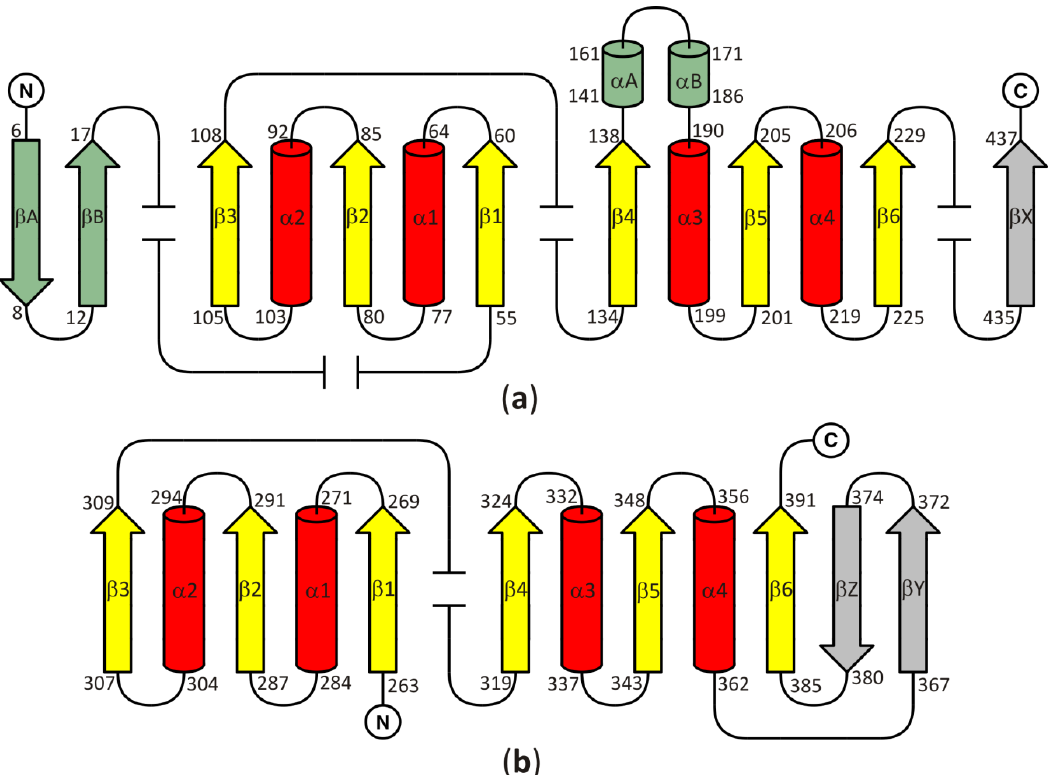
Figure 2. A topology diagram of the Rossmann fold in ( a ) the substrate-binding domain and ( b ) the cofactor-binding domain. Secondary structure elements present in the canonical Rossmann motif are shown in yellow and red. Additional, non-canonical β-chains present in all SAHases, in the central β-sheet, are shown in grey. The secondary structure elements present in the substrate binding-domain (SBD) of plant and numerous bacterial SAHases are shown in green. Other, variable secondary structure elements are omitted (broken lines). The numbering scheme of the secondary structure elements is based on their order in the polypeptide chain of the Rossmann fold-based domains of SAHases. For those elements that are absent in the canonical Rossmann fold, the letter designation is used. Amino acid residue numbers correspond to those of LlSAHase.